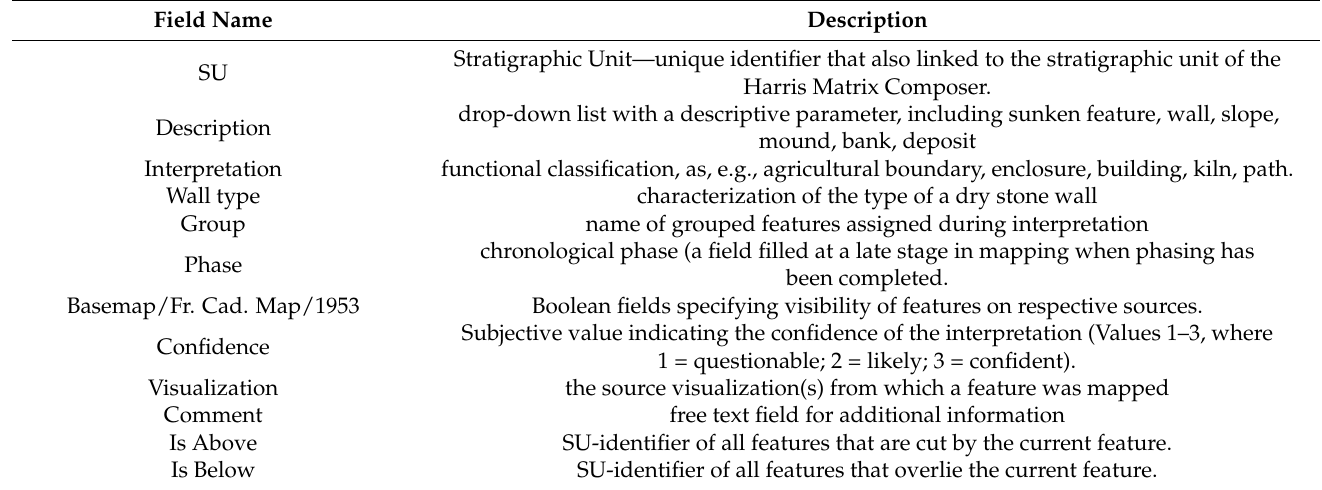
Table 3. Fields in the spatial database used for the GIS-based